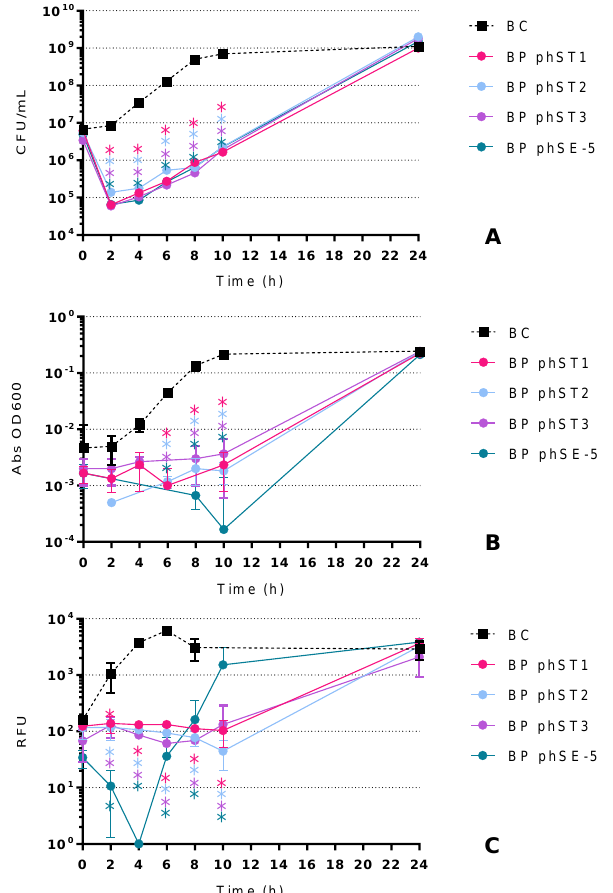
Figure 3. Inactivation of S. Typhimurium by four S. Typhimurium phages (phST1, phST2, phST3 and phSE-5) at an MOI of 10 for 24 h. Bacterial concentration of S. Typhimurium through colony- counting ( A ), optical density ( B ) and cell viability ( C ) methods: BC-Bacteria Control; BP-Bacteria plus Phage. Values represent the mean of three independent assays; error bars represent the standard deviation. * p < 0.05 (relative to the respective control). Some values are missing because they go below the method’s lower detection limit and would go to a negative Y value, and negative numbers cannot be shown on a logarithmic